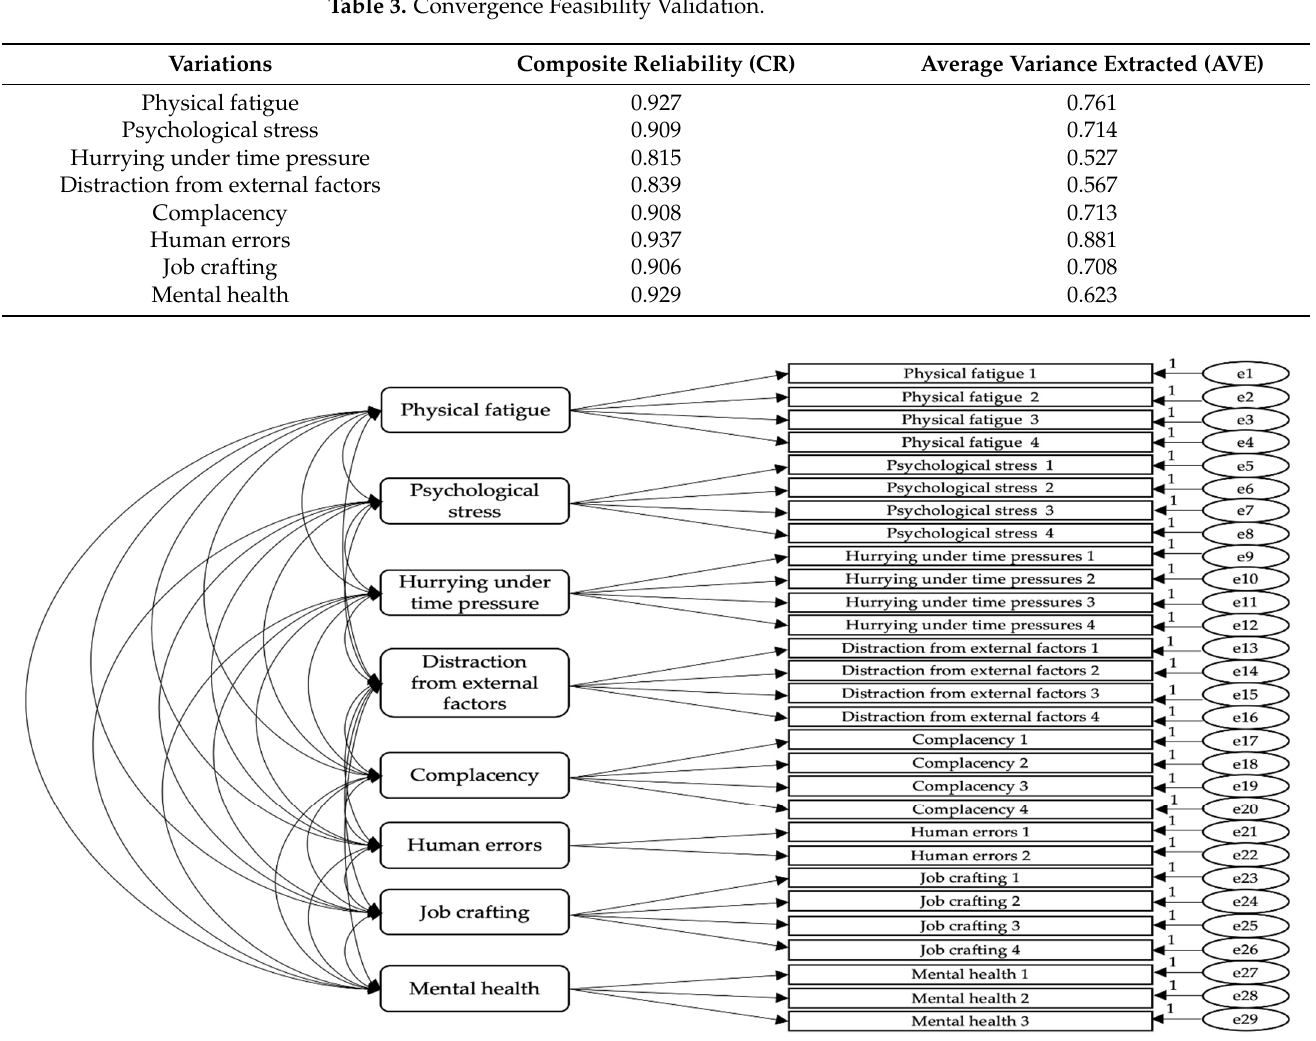
Figure 2. Confirmative Factor Analysis Model.